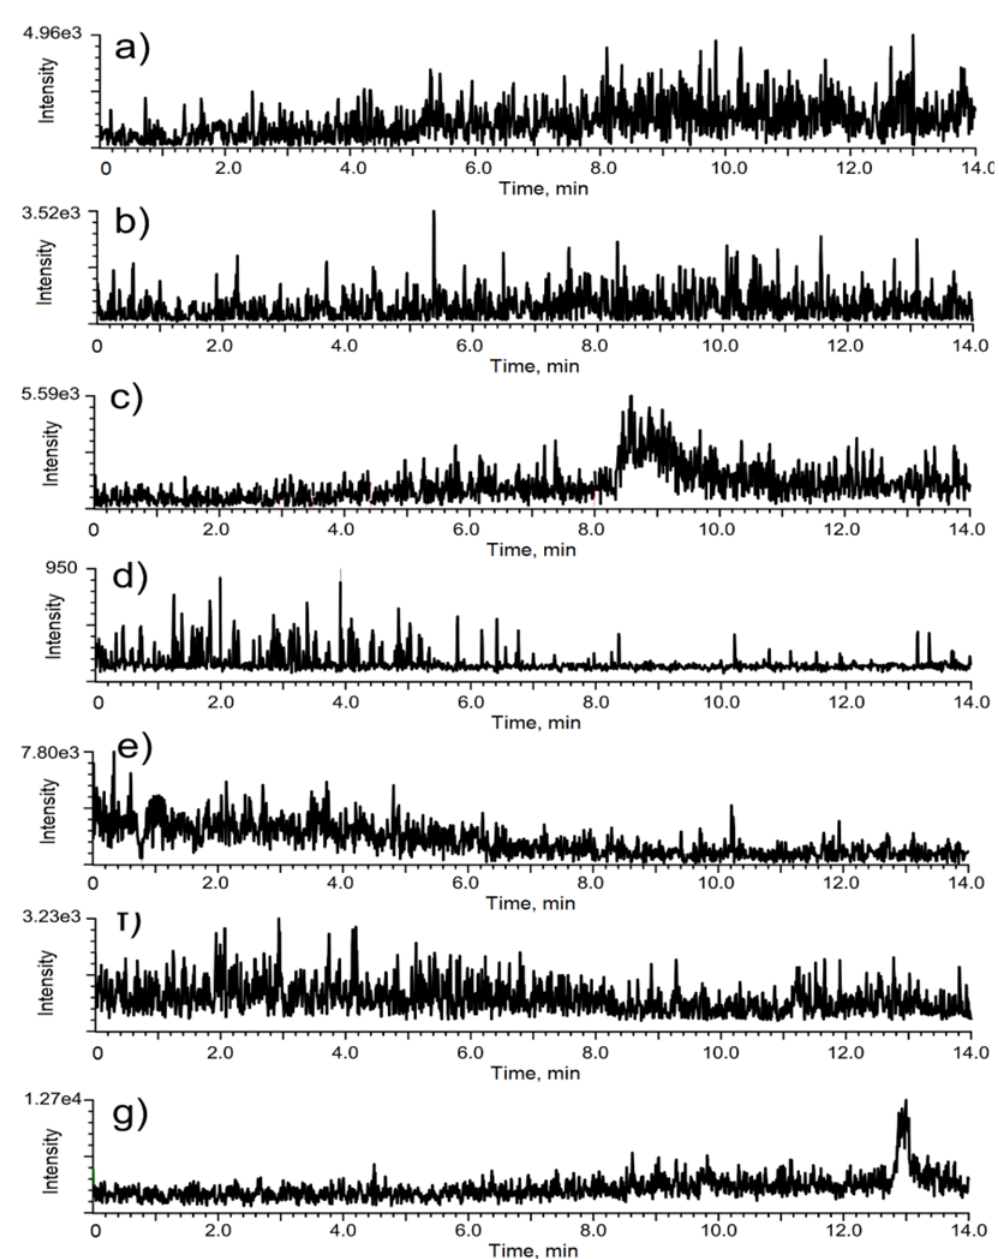
Figure 5. Chromatograms of a blank corresponding to the deep gas storage aquifer water sample ( cf. Figure 4. measured for m / z ( a ) 135.9 → 93.0, ( b ) 193.0 → 149.0, ( c ) 120.9 → 77.0, ( d ) 144.0 → 99.1, ( e ) 207.0 → 163.1, ( f ) 135.0 → 91.0, ( g ) 221.1 → 177.1.